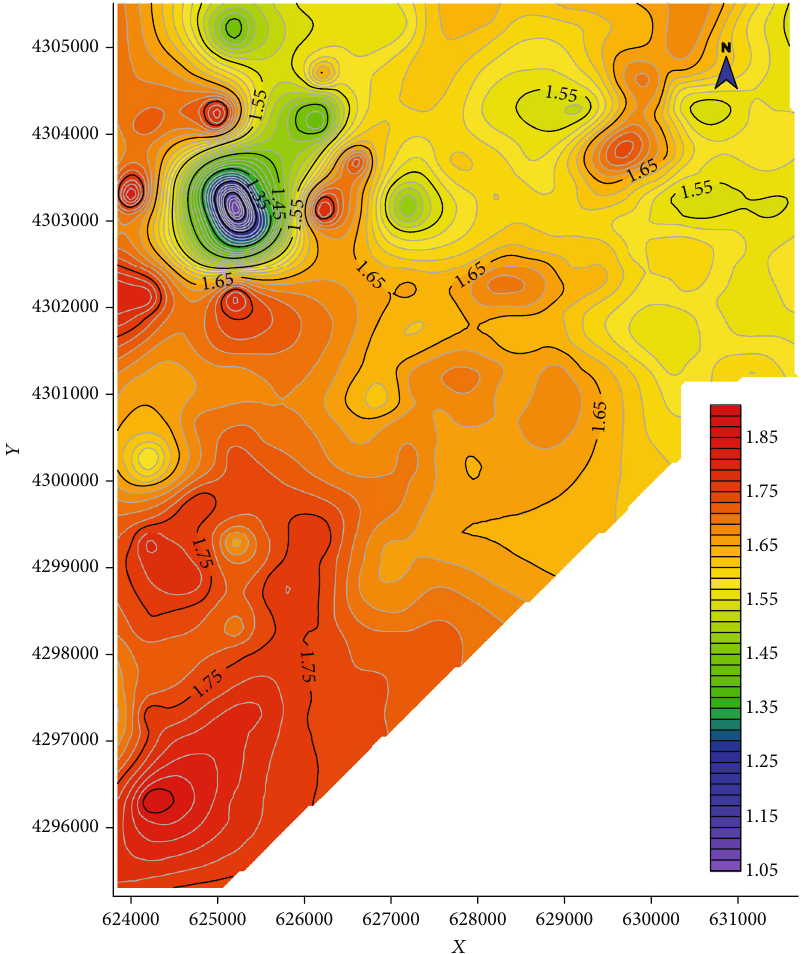
Figure 9: Distribution layout of the stress concentration coe ffi cient of the key